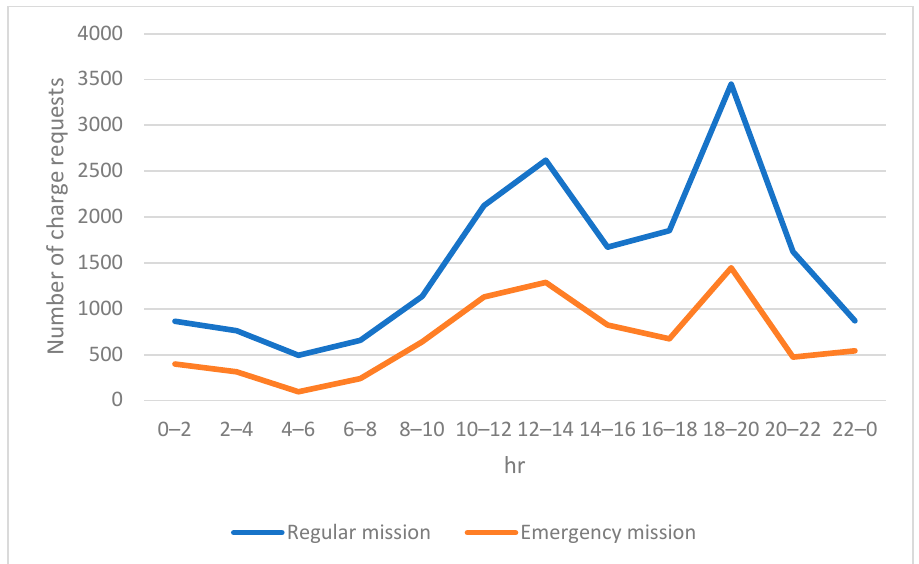
Figure 6. Number of charging requests for UAVs within a day.